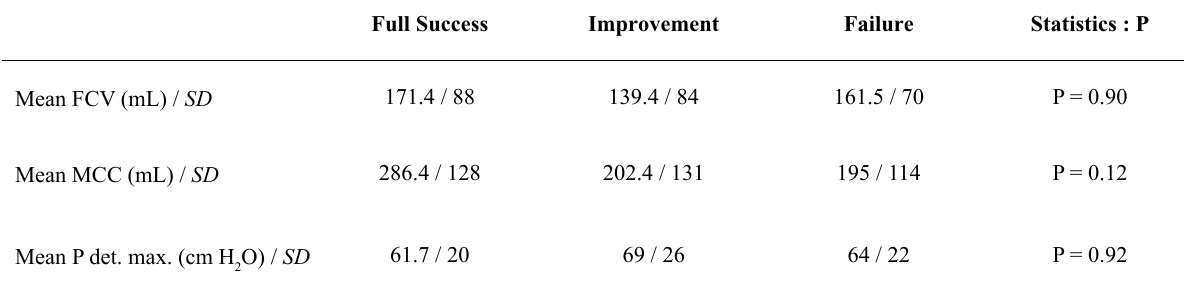
Table 3 - Group analysis. Mean urodynamic criteria before injection.